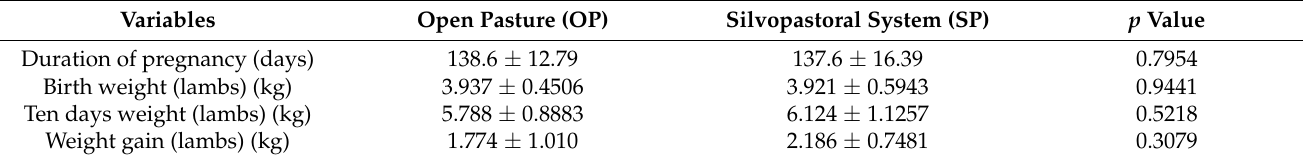
Table 3. Mean values (mean ± SEM) of the reproductive variables and lamb’s weight between rearing systems.